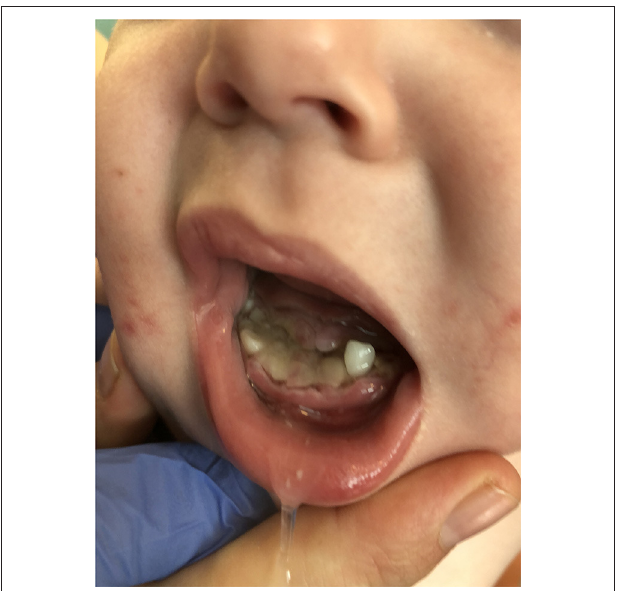
FIGURE 1 | Necrosis of the frontal region of the mandibular alveolar ridge and three missing